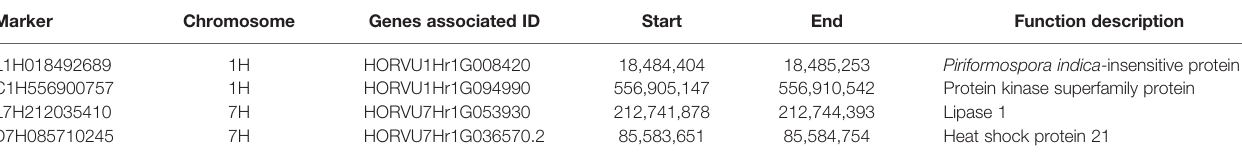
TABLE 6 | Genes close to or embedding signi fi cant markers associated with salinity tolerance at germination. Marker